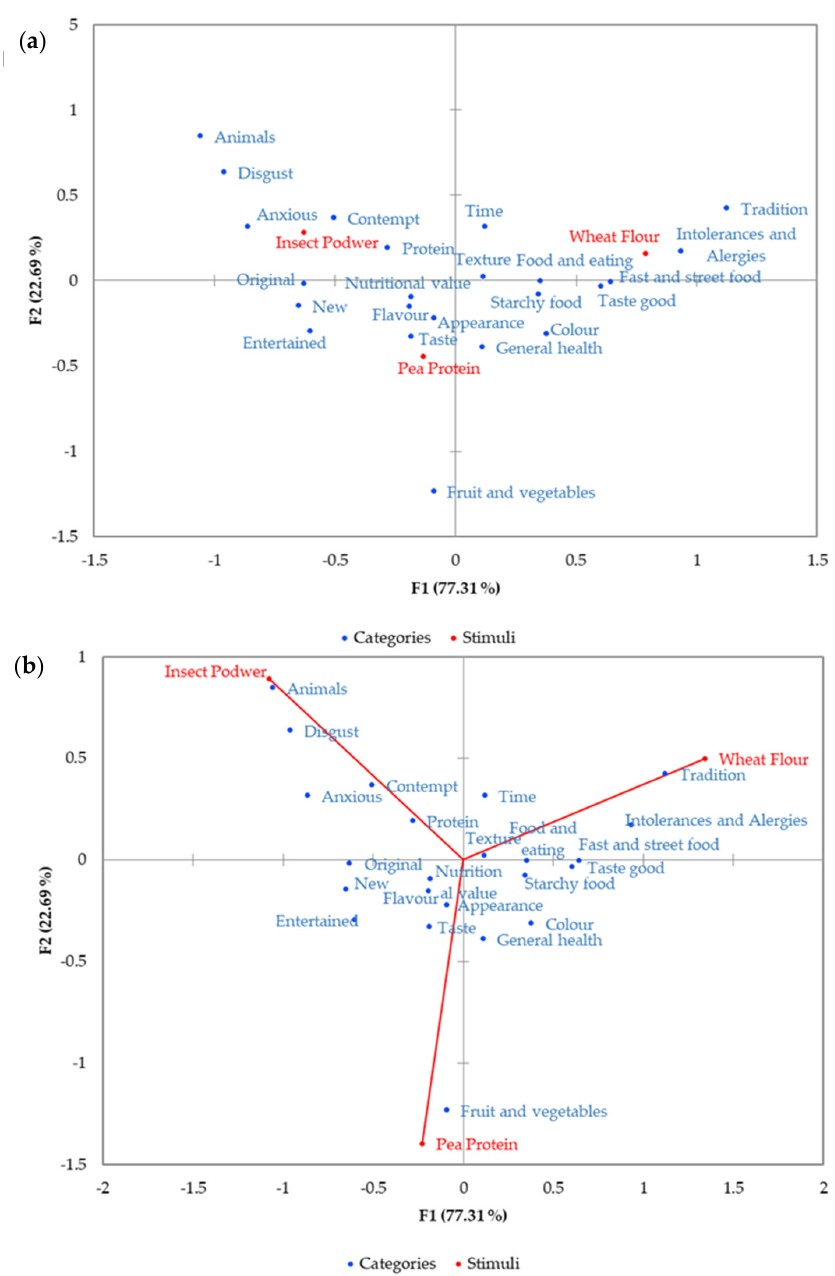
Figure 3. Correspondence analysis of contingency table. ( a ) Symmetric plot; ( b ) Asymmetric plot.